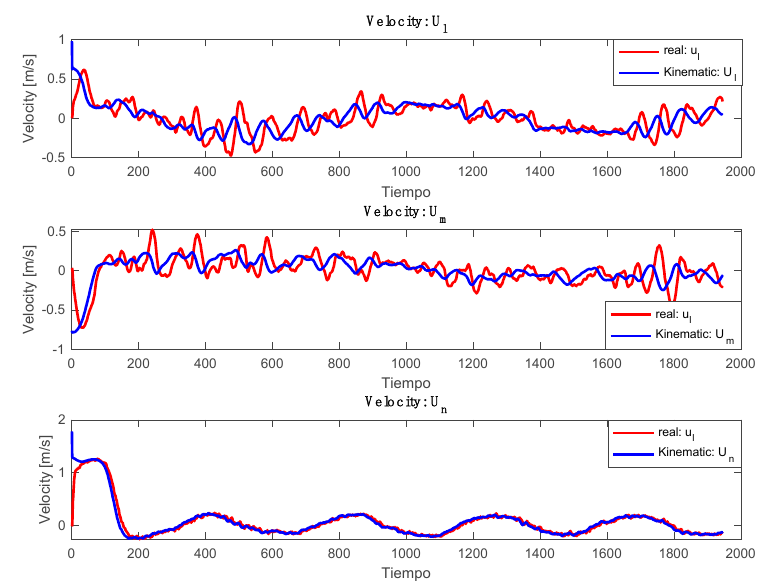
Figure 16. Control signals: LAMDA controller.